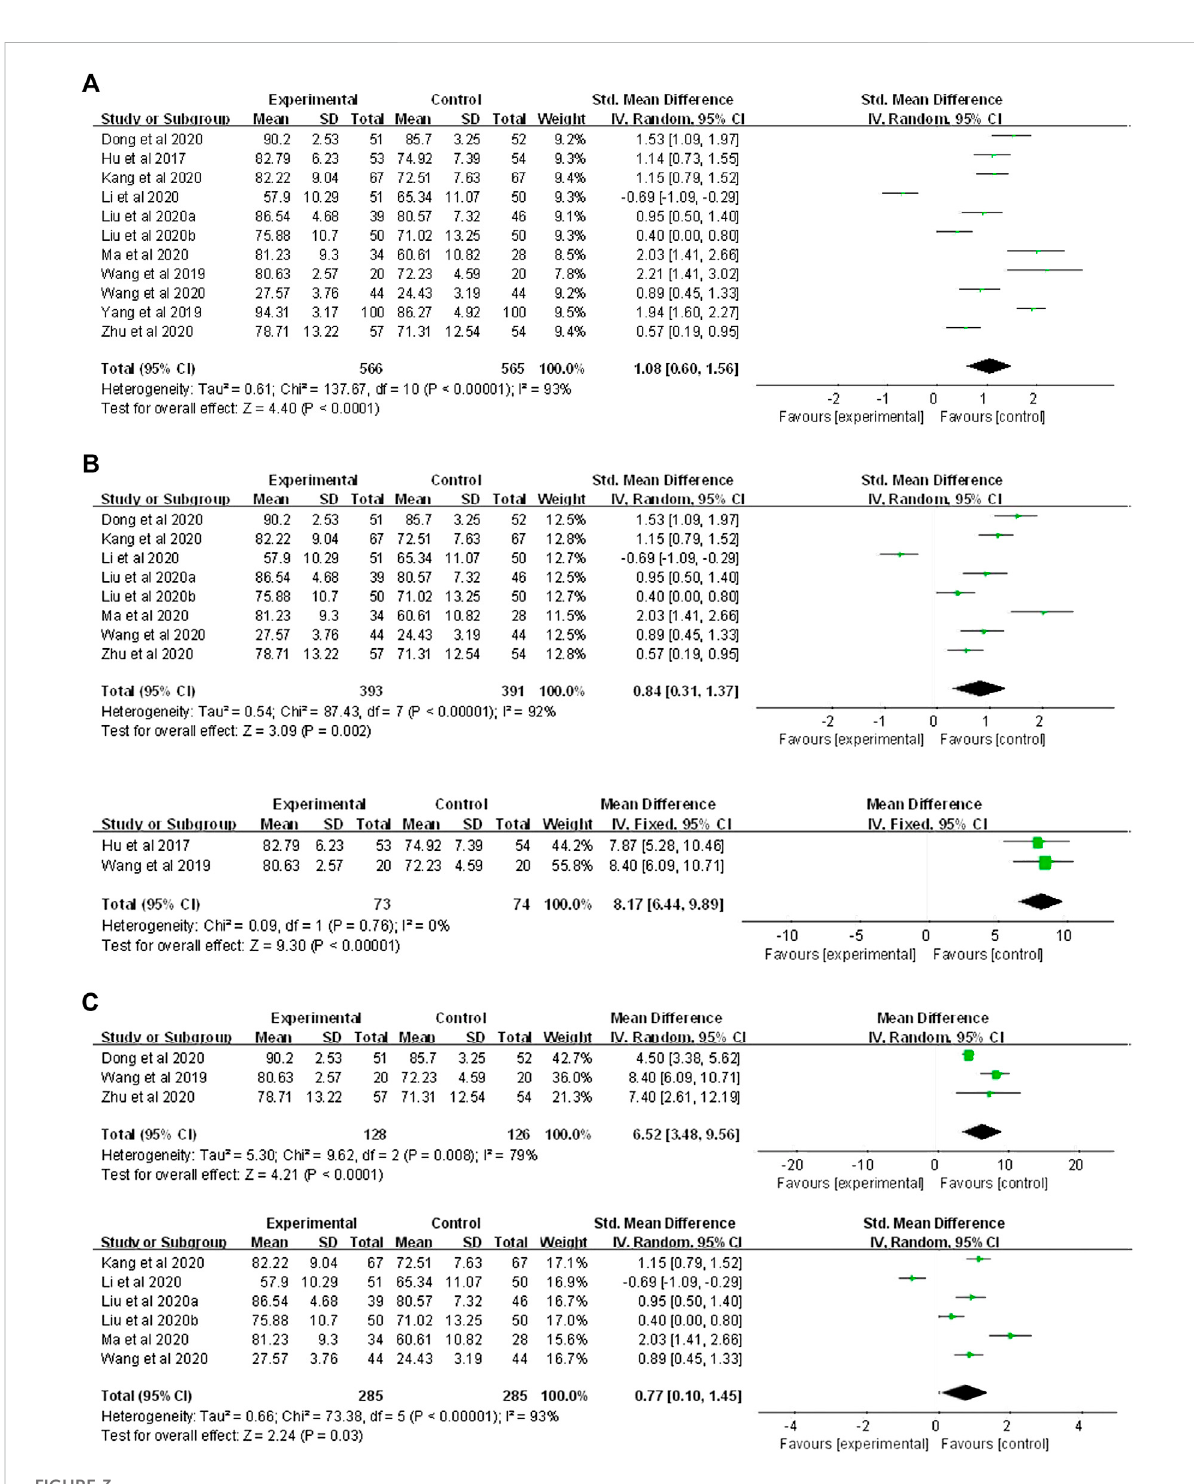
FIGURE 3 Forest plot for effectiveness of FC versus LBL in (A) theoretical test score; (B) undergraduate versus 3-year junior-college student subgroup analysis (C) theory- and experimental-oriented curriculum subgroup